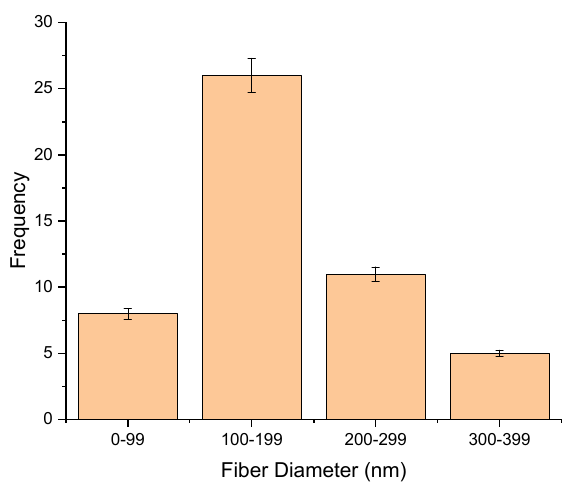
Figure 1. NFs formed with 0.5% of CEO ( A ), fibers formed with 1% of CEO ( B ), fibers formed with 60:40 ratio ( C ) and fibers formed with 70:30 ratio ( D ).